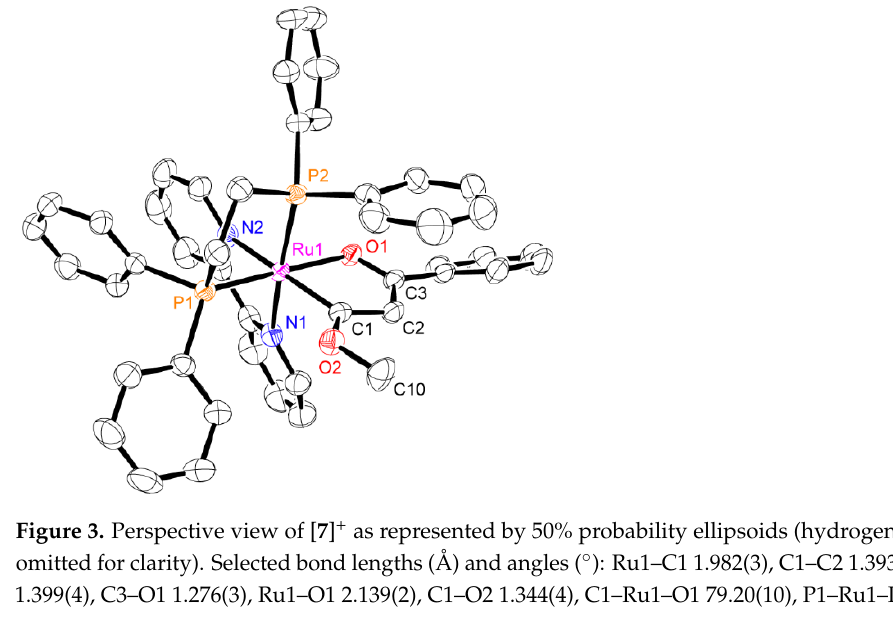
5 of 14 Figure 2. Perspective views of [ 4 ] + (left) and [ 5 ] + (right) as represented by 50% probability ellipsoids (hydrogen atoms are omitted for clarity). Selected bond lengths (Å ) and angles (°): [4] + : Ru1−C1 1.964(6), C1−C2 1.414(8), C2−C3 1.413(8), C3−O1 1.271(7), Ru1−O1 2.127(4), C1−O2 1.339(7), C1−Ru1−O1 79.4(2), P1−Ru1−P2 72.07(5) ; [ 5 ] + : Ru1− O1 2.166(2) , Ru1−C1 1.967(4) , Ru1− P1 2.2311(9), C1−C2 1.375(5) , C2−C3 1.441(5) , C3−O1 1.267(4) , C1−P2 1.794(4) , P2−C10 1.802(4) , P1−C10 1.858(4), P1−Ru1−C1 89.31(10) , C1−Ru1−O1 77.10(12). The formation of [ 4 ] + and [ 5 ] + in the reaction between HC≡C(C=O)Ph and 1 revealed that there are two competing reactions for the Ru−vinylidene intermediate , namely inter- molecular nucleophilic attack by − OMe originated from the solvent MeOH, and intramo- lecular nucleophilic attack by the auxiliary ligand dppm. However, such competition was not observed in the reaction between HC≡C(C=O)Ph and 2 in MeOH, where methoxy- substituted ruthenafuran [Ru(bpy)(κ 2 -dppe)(C^O)] + ([ 7 ] + ) was found to be the only prod- uct (Scheme 3a). The difference in reactivity between 1 and 2 may be attributed to their